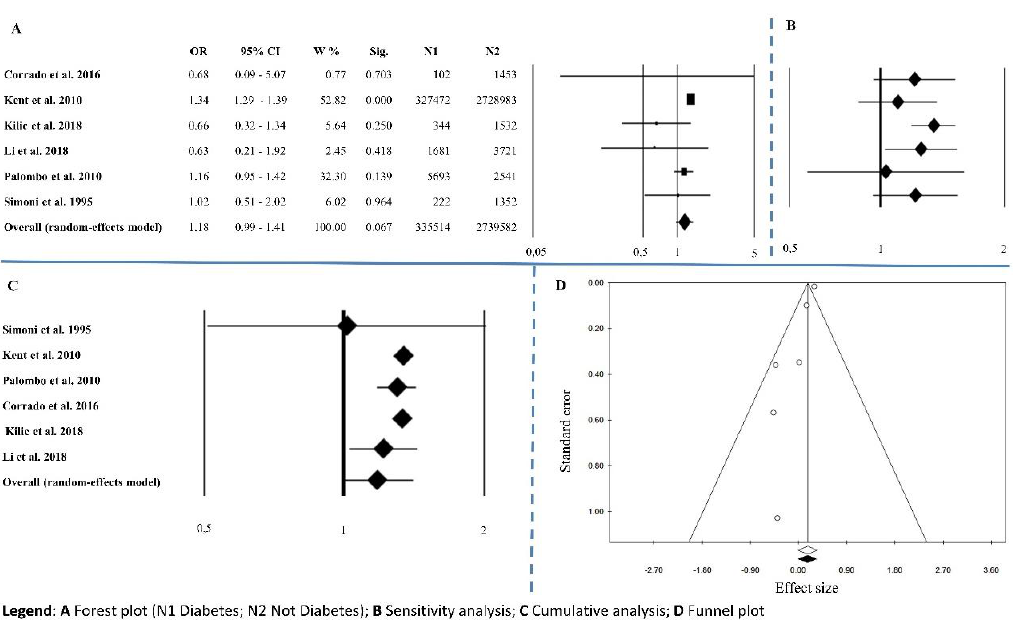
Figure 5. Diabetes. ( A ) Forest plot (N1 Diabetes; N2 Not Diabetes); ( B ) sensitivity analysis; ( C ) cumulative analysis; ( D ) funnel plot.